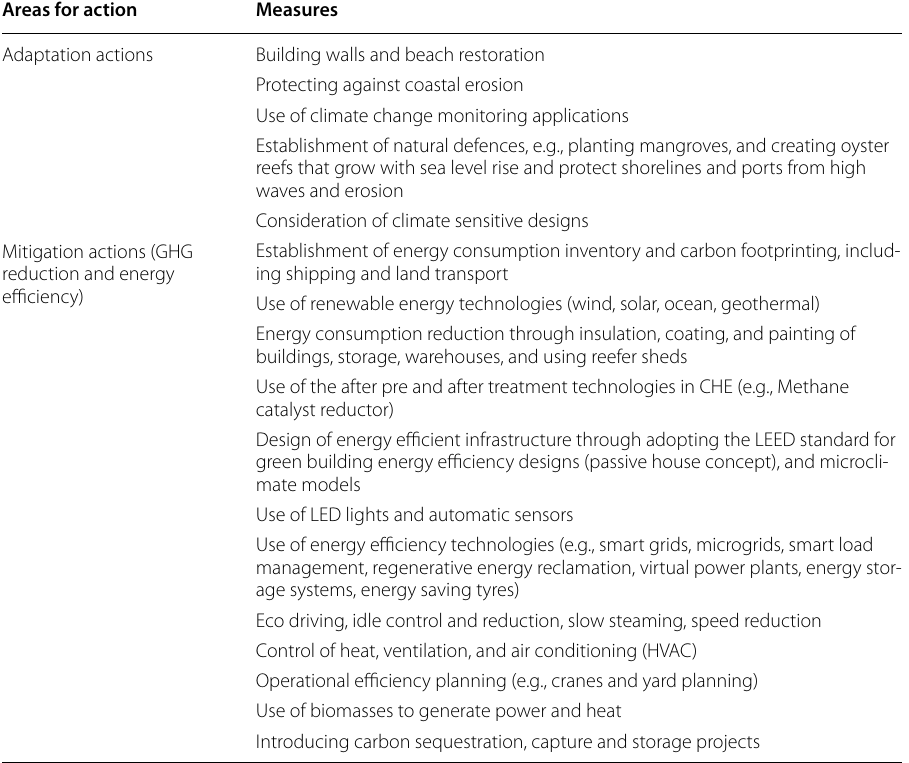
Table 5 Climate change mitigation and adaptation actions and measures. Sources : Villalba and Gemechu (2011), I2S2 (2013), Ng et al. (2013), PIANC (2014), UNCTAD (2017), Iris and Lam